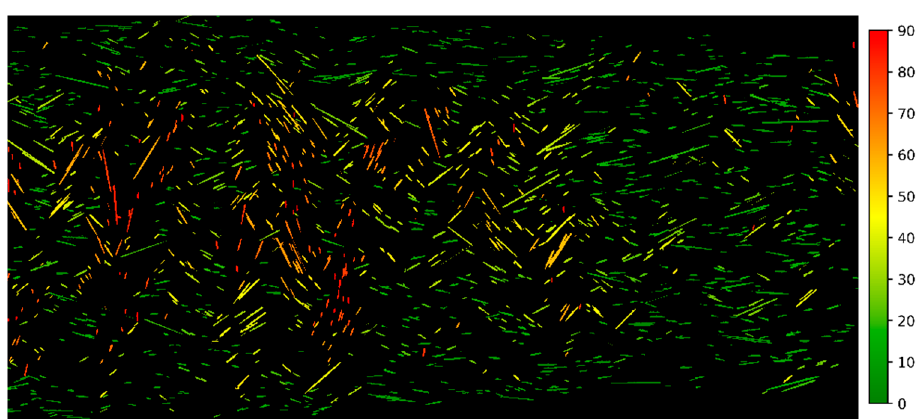
Figure 13. Fiber orientation in N19 with color coded deviation from X.